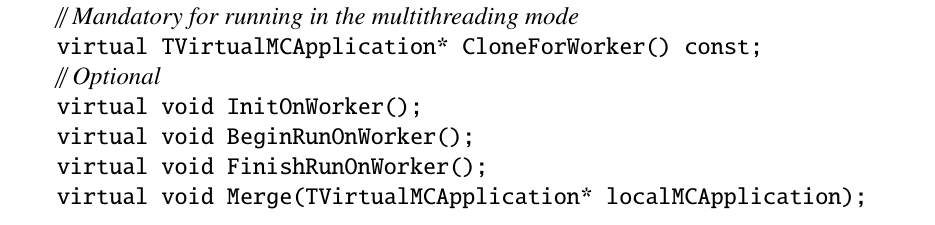
Table 1. Revisited TVirtualMCApplication functions for